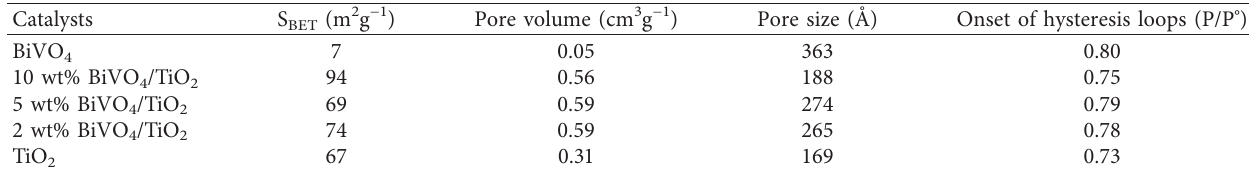
Table 2: Specific surface area (S BET ), pore volume, average pore diameter, and onset hysteresis loops (P/P chemisorption at 77 K using the BET equation.